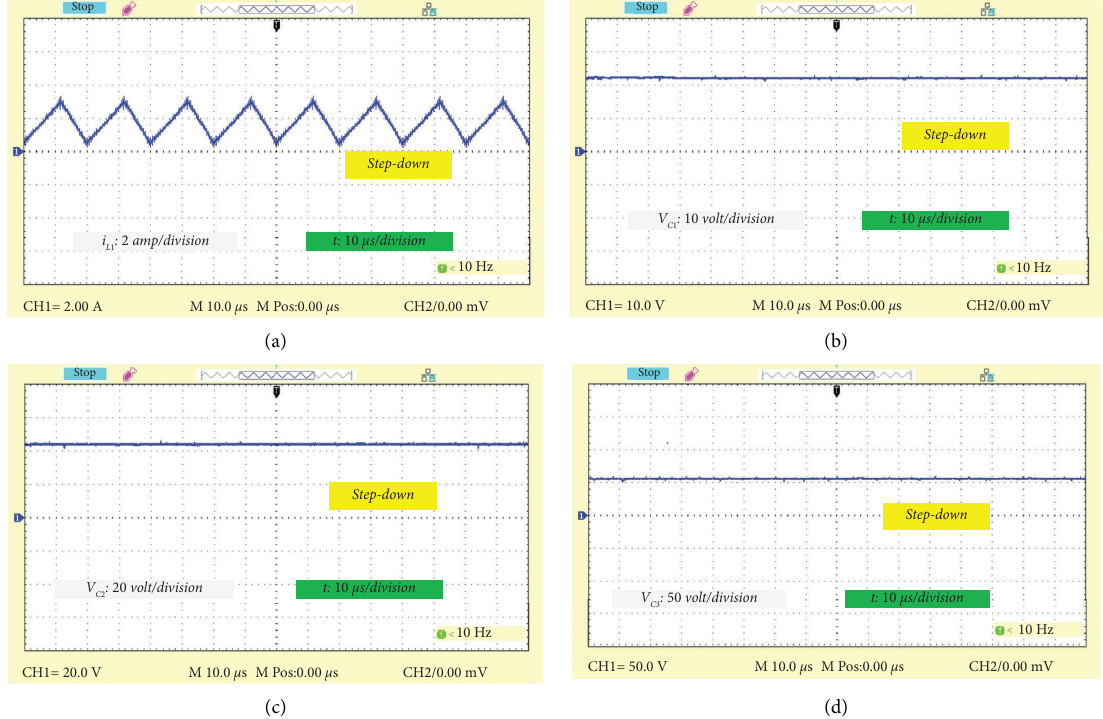
Figure 14: Waveforms in step-down operation: (a) i